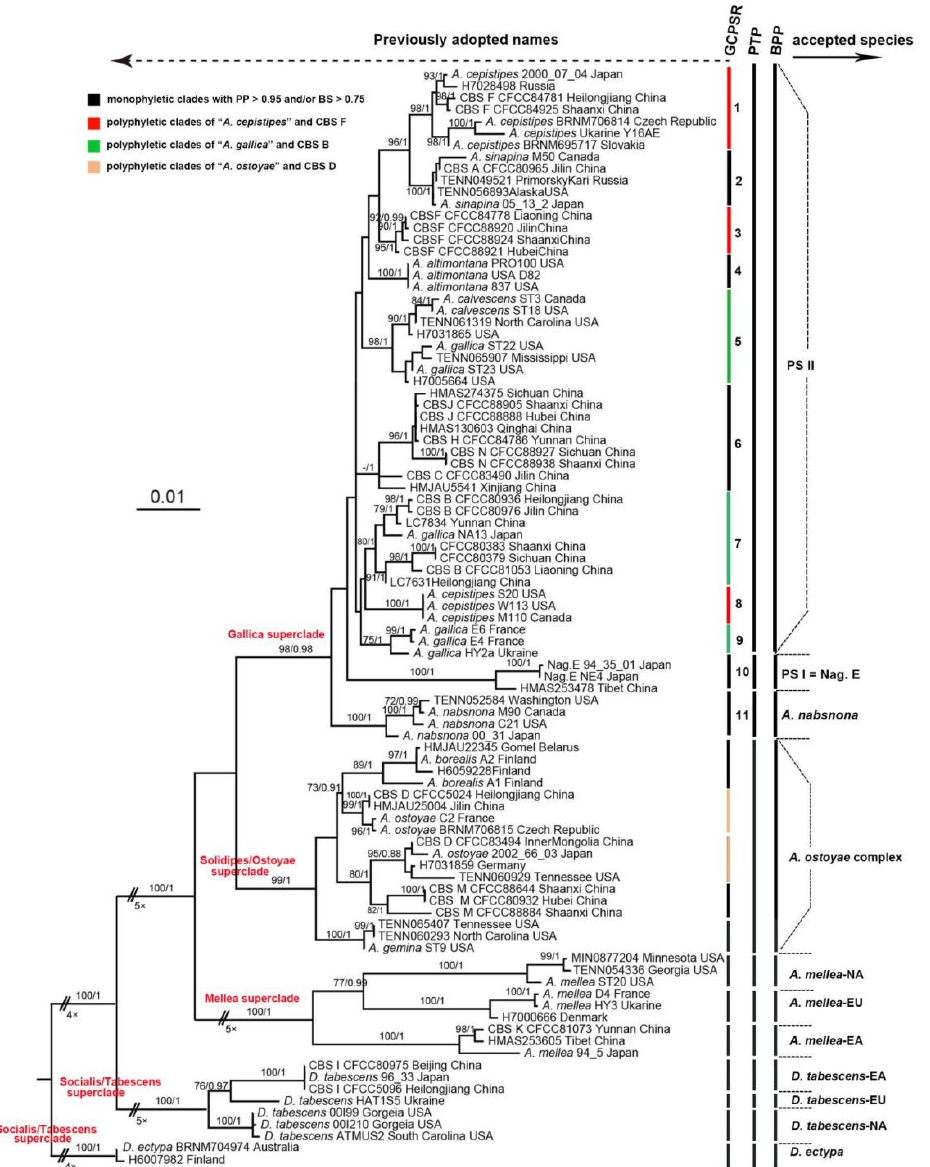
Figure 2. Species delimitation of Armillaria and Desarmillaria based on a phylogenetic constructed using Dataset II (ITS+IGS-1+TEF-1 α )) consisting of 93 representative strains. Only maximum likelihood bootstraps (LBs) over 70% and Bayesian posterior probabilities (PPs) over 0.95 are shown on the branches.